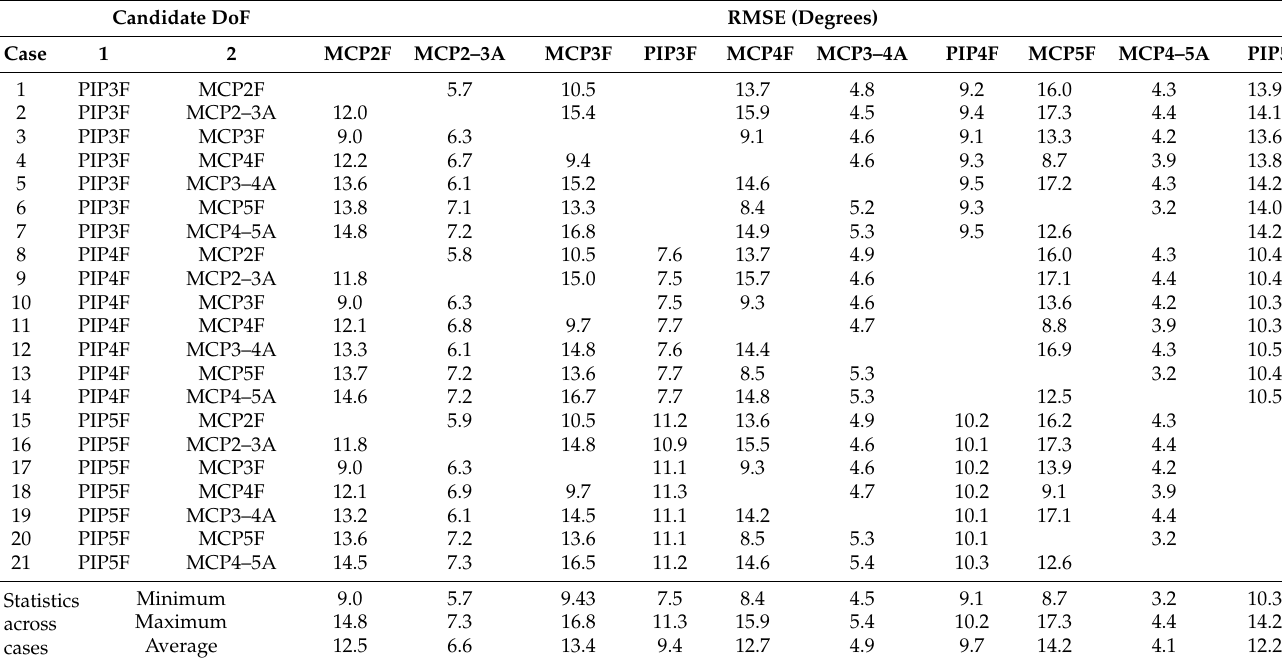
Table 3. RMSE between estimated and recorded joint angles across subjects and actions (for each combination of candidate DoF). 1 to 5 refers to thumb to little fingers. F stands for flexion/extension and A for abduction/adduction movements. Candidate DoF RMSE (Degrees)